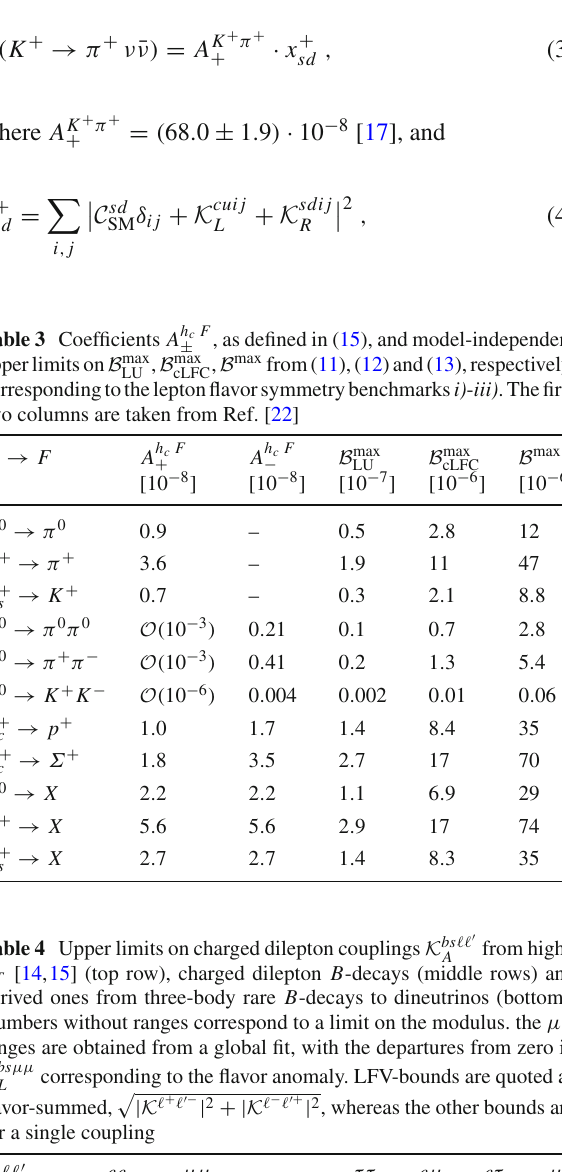
ranges are obtained from a global fit, with the departures from zero in K bs μμ corresponding to the flavor anomaly. LFV-bounds are quoted as (cid:9) L | K (cid:4) + (cid:4) (cid:2)− | 2 + | K (cid:4) − (cid:4) (cid:2)+ | 2 , whereas the other bounds are flavor-summed,